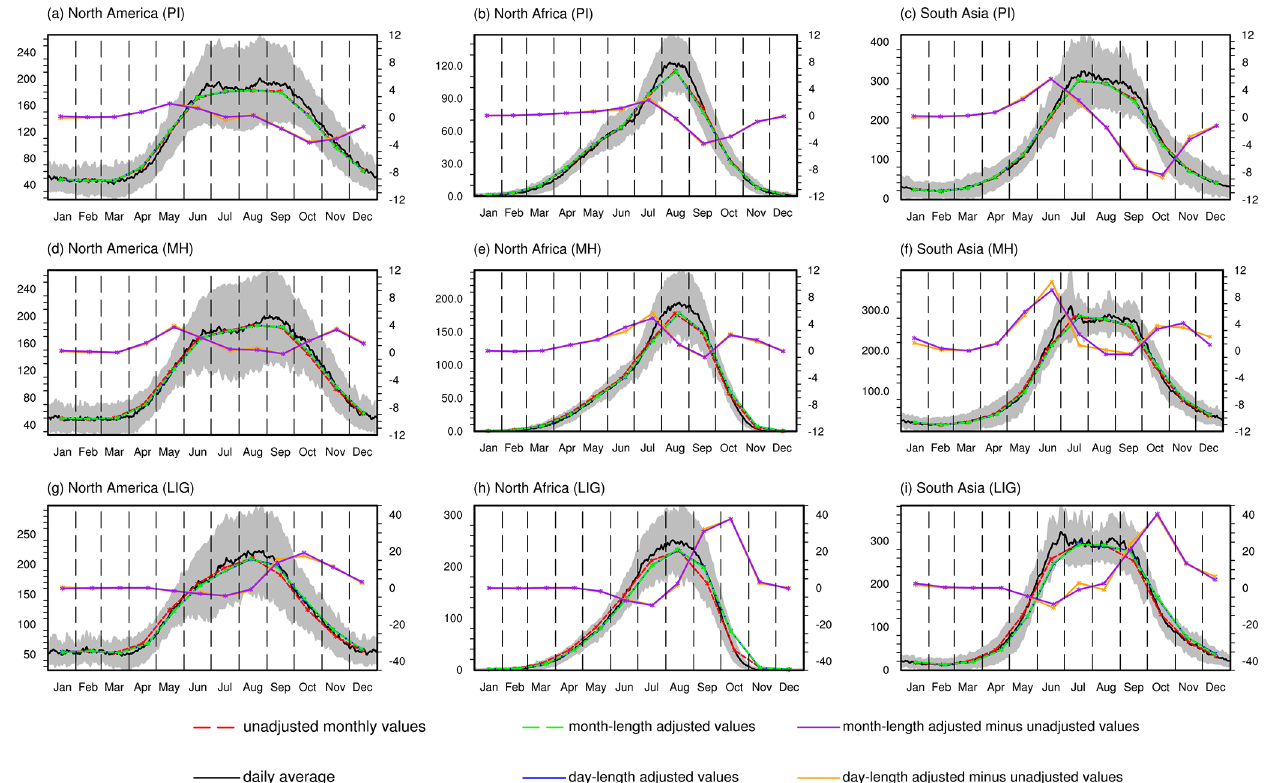
Figure 11. Ensemble seasonal cycle of regional mean precipitation in daily average (black solid lines), classical monthly means (red dashed lines), day-length adjusted means (blue dashed lines), and month-length adjusted means (green dashed lines) for (a–c) PI, (d–f) MH, and (g–i) LIG. Grey area represents 1 standard deviation from the multi-model ensemble daily mean values. Purple (orange) solid line represents the month-length (day-length) adjusted minus unadjusted values (axis to the right). The values are calculated by averaging the precipitation over (a, d, g) North America, (b, e, h) northern Africa, and (c, f, i) South Asia. Units: mm per